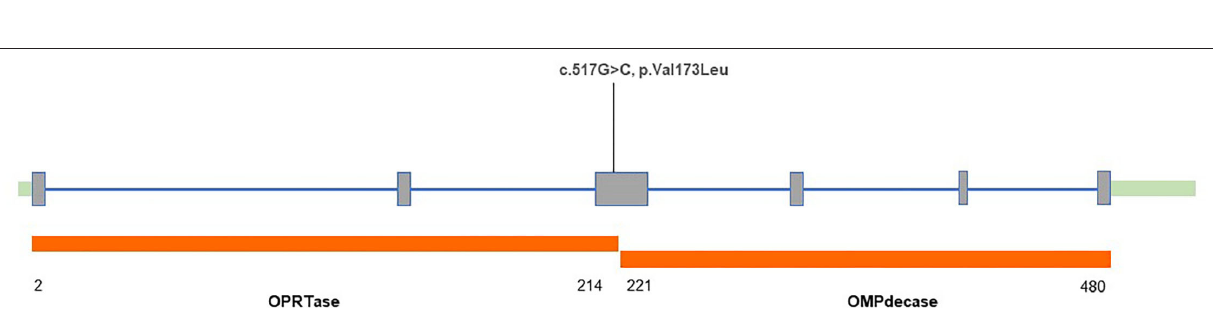
Frontiers in Neurology |